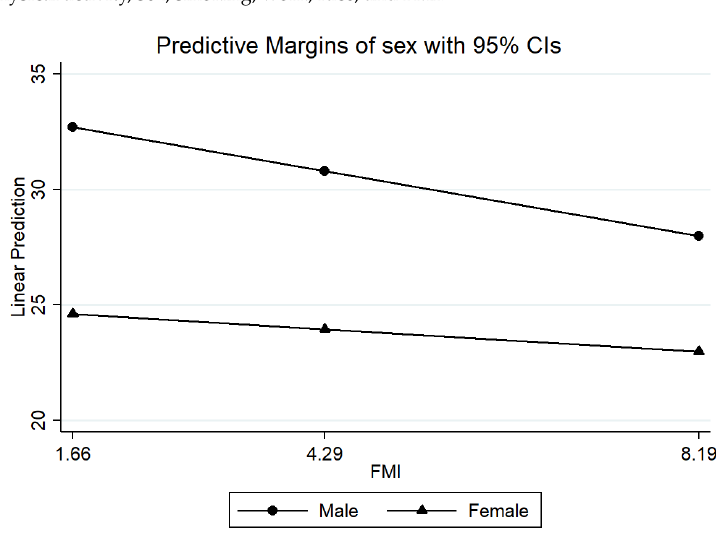
Figure 2. Probabilities predicted by sex compared to fat mass index with grip strength in adolescents. São Luís, Maranhão, Brazil, 2016/2017.